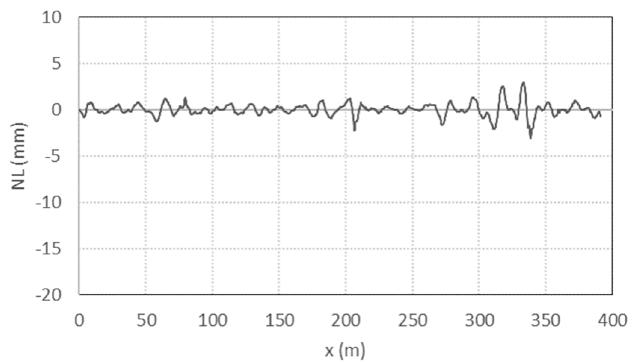
Figure 4. Distributed irregularity of the longitudinal level.